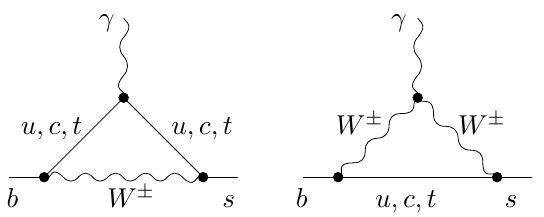
Figure 1. Leading-order Feynman diagrams for b → sγ in the